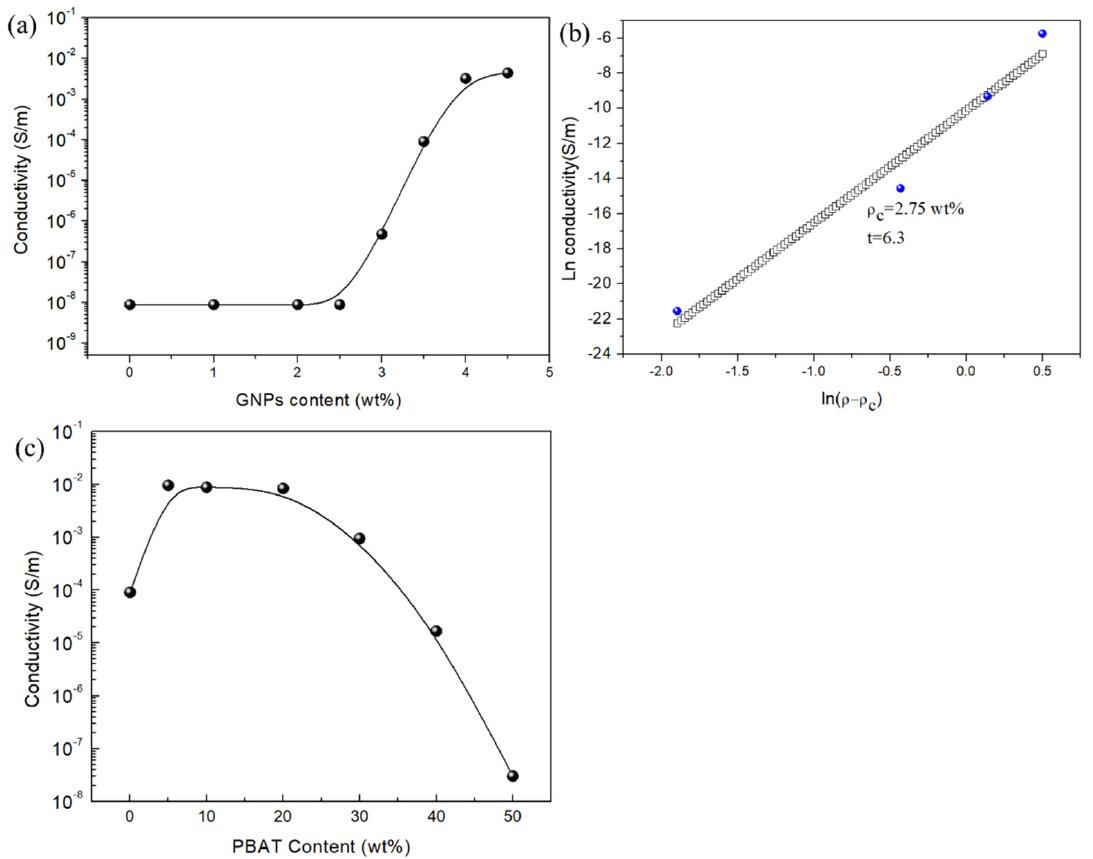
Figure 2. ( a ) Electric conductivity of PLA/GNPs composite, ( b ) the fitting curves of electric conductivity, and ( c ) electric conductivity curve of PLA/PBAT/GNPs composite as a function of PBAT con- tent.